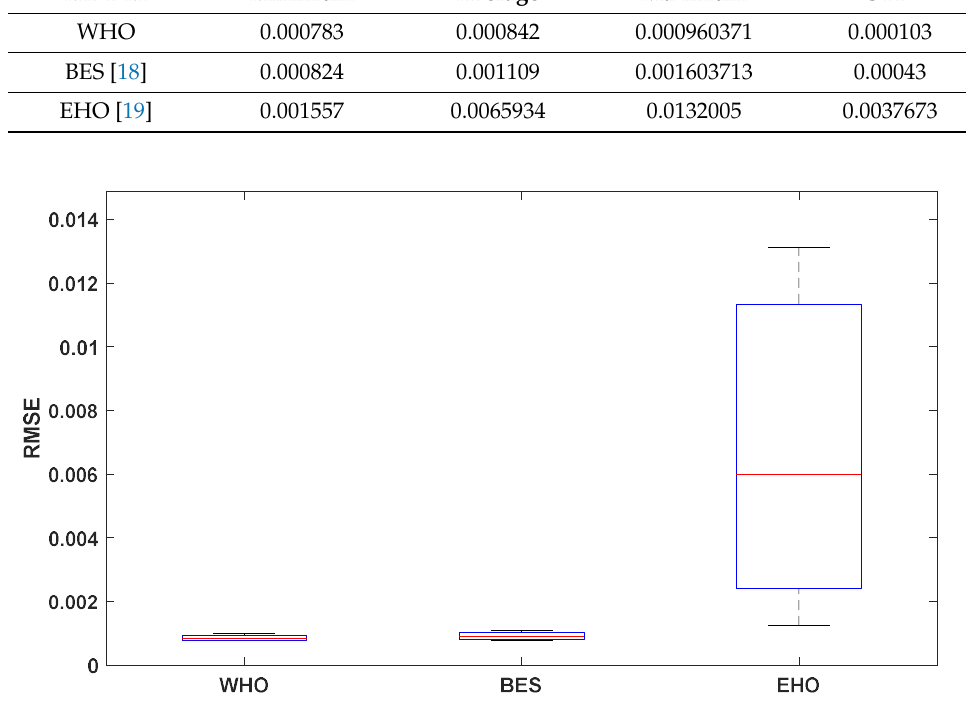
Figure 10. Boxplot figure of all algorithms for 30 independent runs applied to MTDM. Table 4. The statistical results of MDDM for WHO and other algorithms.